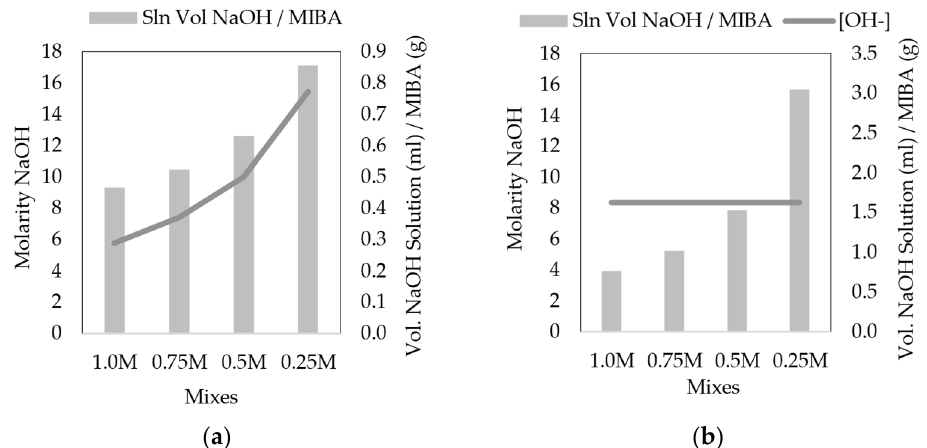
Figure 5. Concentration and volume of the alkaline solution in the pre-treatment of MIBA: ( a ) OAA design and ( b ) CAA design.